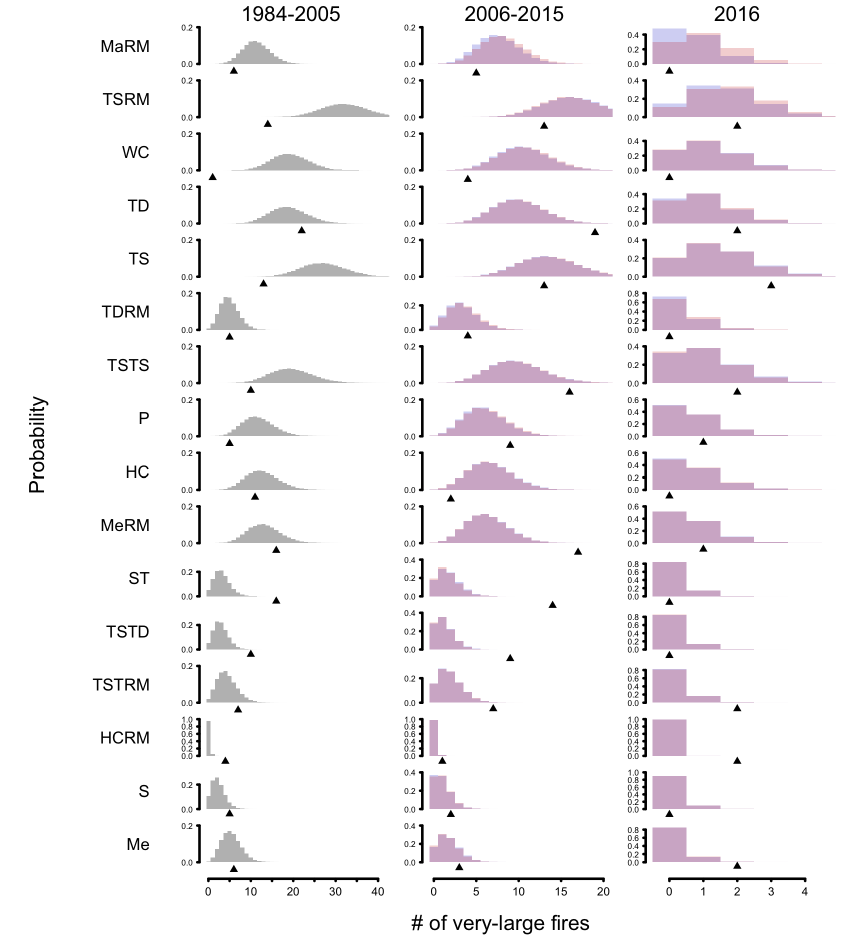
Figure 7. Simulated and actual very-large fire month counts for each region and three time periods: 1984–2005, 2006–2015, and 2016. A sample of 100,000 simulated very-large fire (VLF) counts are produced under historical (grey), RCP 4.5 (blue), and RCP 8.5 (red) scenarios by randomly selecting a VLF probability time series from the posterior and randomly generating a VLF occurrence time series. The observed VLF counts are represented with